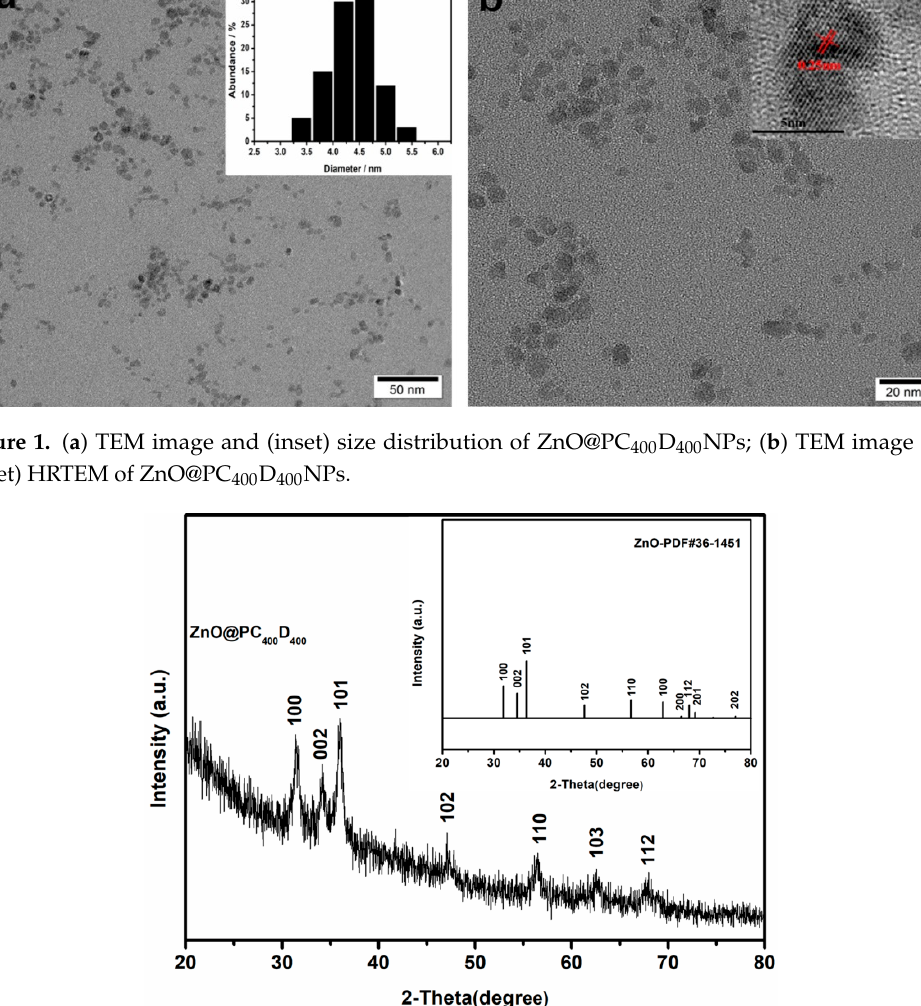
Figure 2. XRD patterns of ZnO@PC 400 D 400 NPs (the right upper inset was the standard pattern of ZnO (JCPDS 36-1451)).